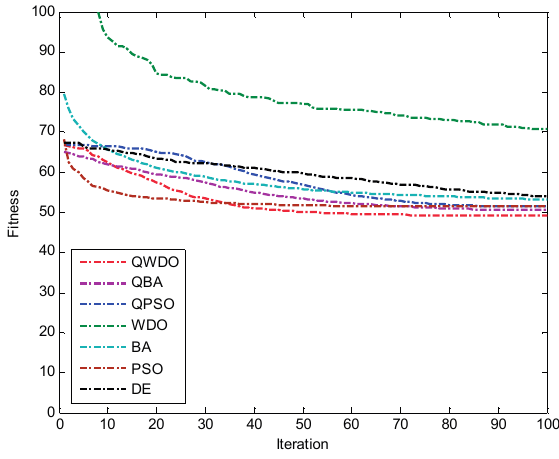
Figure 18. Fitness of the second instance for Maxgen = 50.